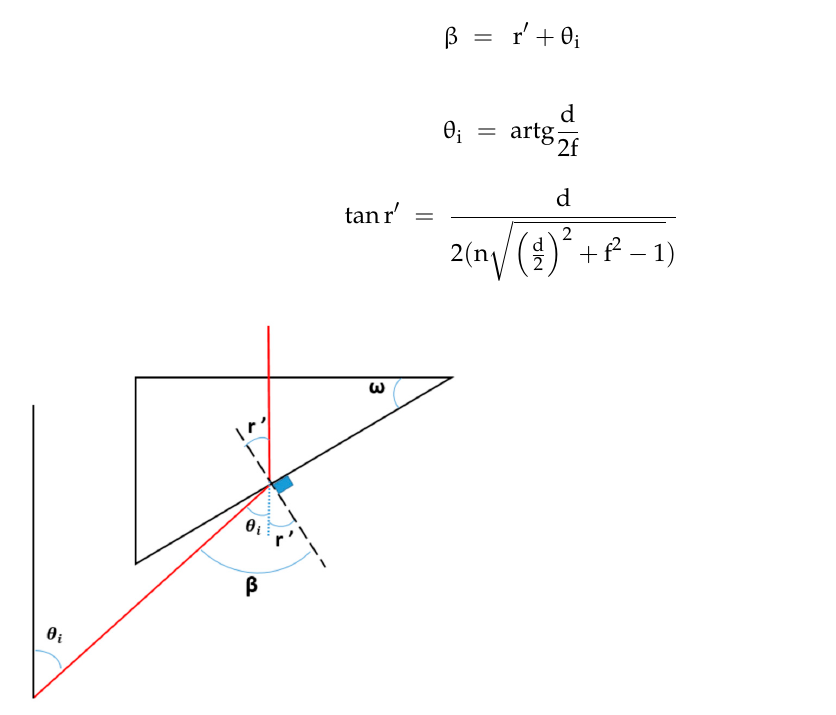
Figure 3. The inward-facing prism of the Fresnel